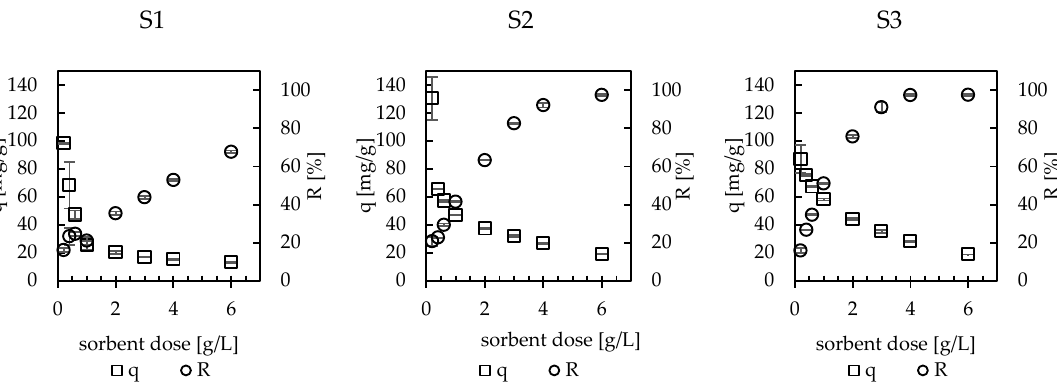
Figure 8. Effect of sorbent dose on sorption capacity (q) and removal efficiency (R) (c = 115 mg/L, V = 0.02 L, pH = 6, temp. = 22 ± 1 °C, t = 24 h).